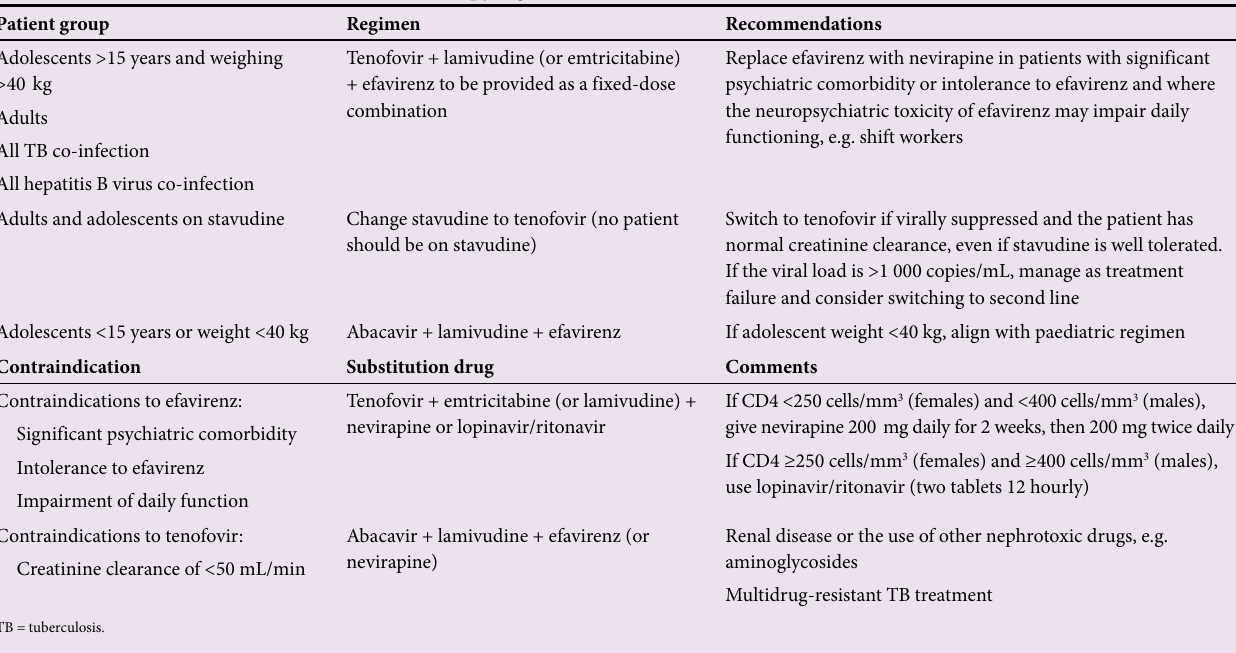
Table 1. Standardised first-line antiretroviral therapy regimens for adults and adolescents in SA